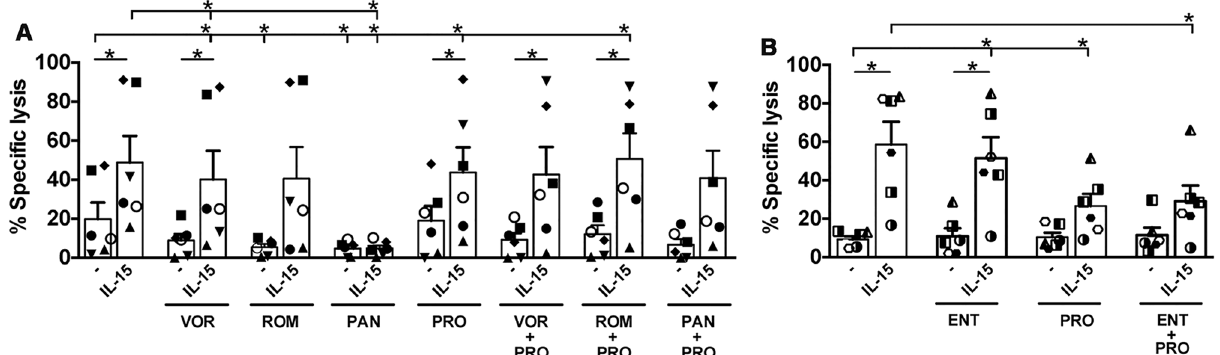
Figure 3. Impact of IL-15/LRA combinations on NK-cell cytoxicity. NK cells cultivated for 72 h without stimuli or with IL-15, HDACi or PRO alone or in HDACi + PRO combinations with or without addition of IL-15, were tested for cytotoxicity against K562 cell targets. The percent of specific lysis was calculated in six independent donors for pan-HDACi ( A ) as well as for ENT ( B ) combinations (each symbol represents one individual donor). The bars represent mean ± SEM. Comparisons were performed using paired Wilcoxon test versus unstimulated control, IL-15 alone, and LRA without IL-15. * p <